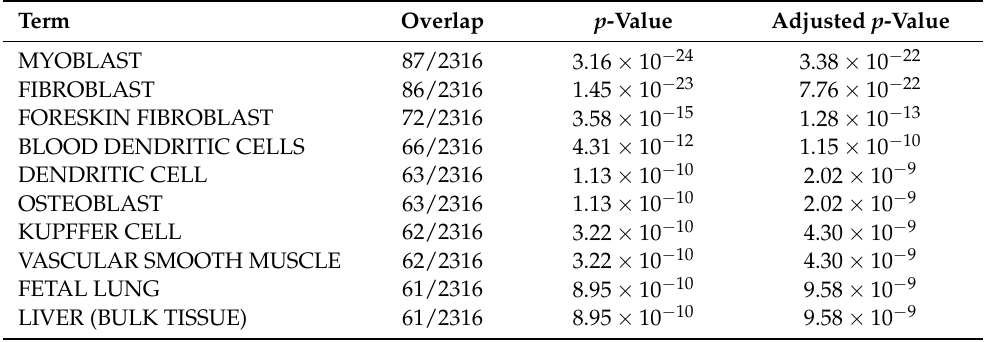
Table 6. The top 10 enriched terms in “ARCHS4 Tissues” using Enrichr. Overlap is the number of common genes between the genes uploaded and the genes in the category divided by the number of genes in the category. Probes, whose associated genes were uploaded to Enrichr, were identified using PCA-based unsupervised